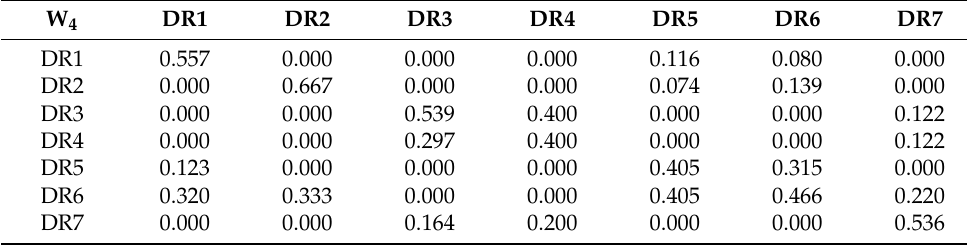
Table 11. Relative weights of DRs with respect to each DR (W 4